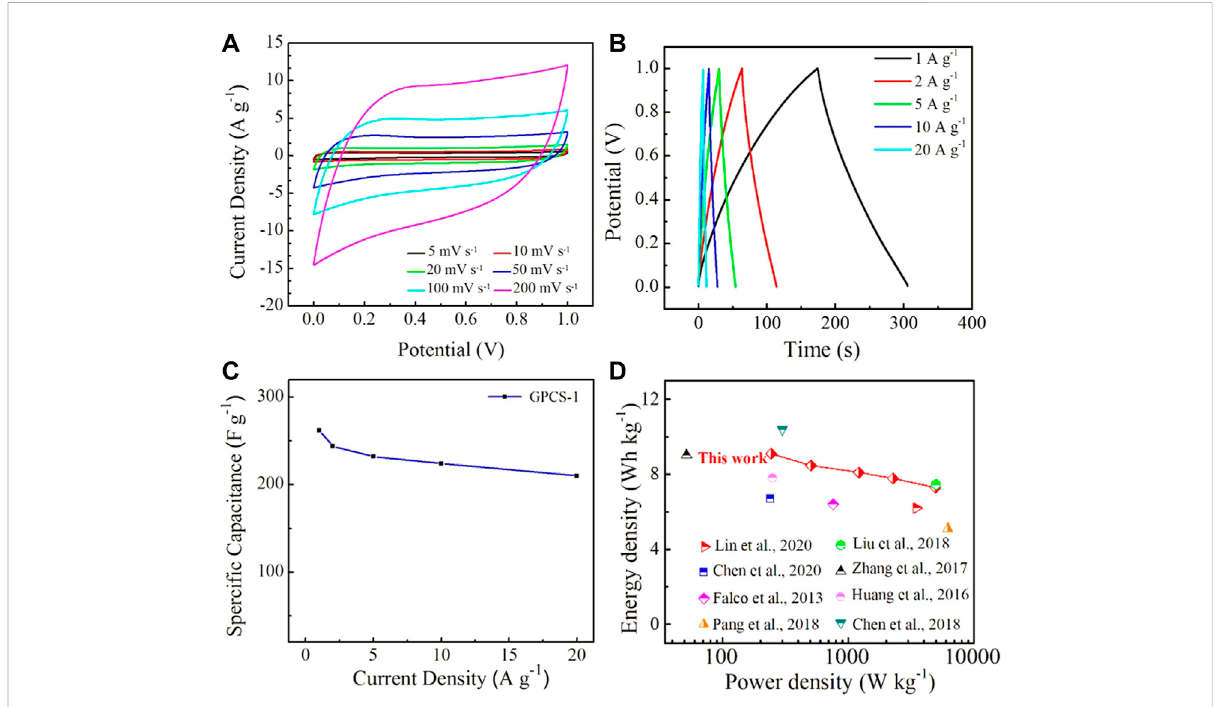
FIGURE 7 (A) CV curves of GPCSs-1 symmetric supercapacitor in 1 M H 2 SO 4 aqueous electrolyte at various scan rates ranging from 5 to 200 mV s − 1 . (B) GCD curves of GPCSs-1 symmetric supercapacitor in 1 M H 2 SO 4 aqueous electrolyte at different current densities ranging from 1 to 20 A g − 1 . (C) Speci fi c capacitances versus different current densities. (D) Comparison of the Ragone plot of GPCSs with those of some representative carbon- based supercapacitors from